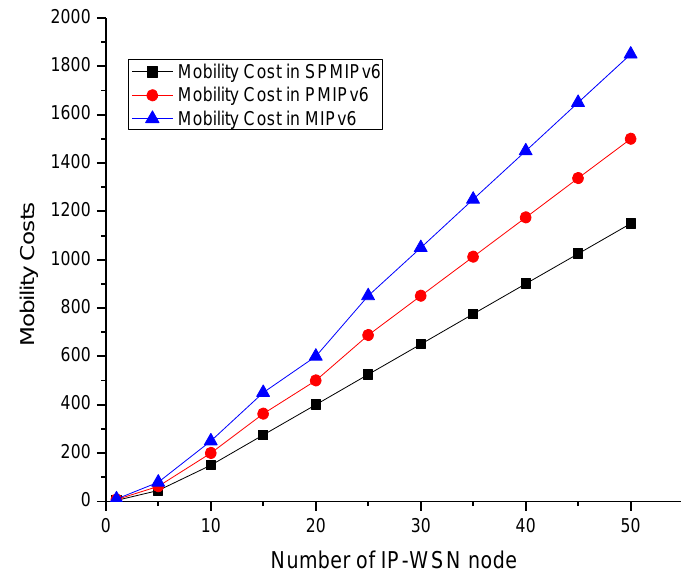
Figure 11. Number of IP-WSN nodes vs. Mobility